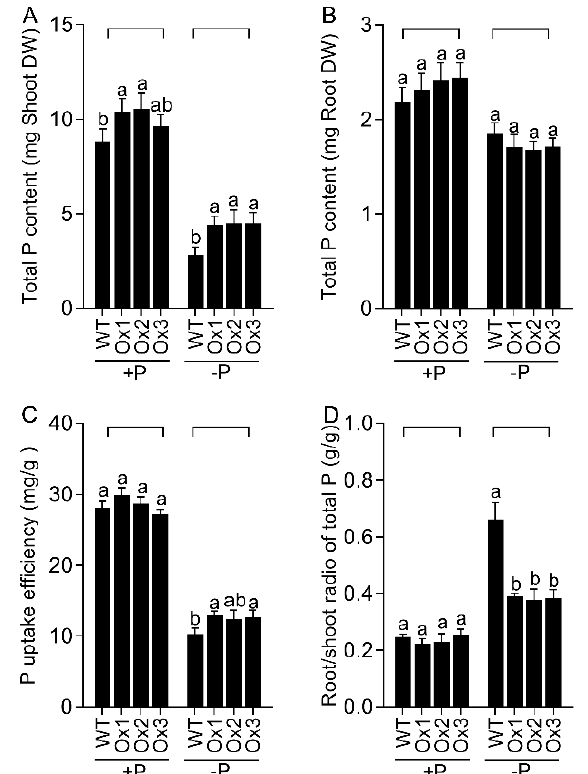
Figure 3. Overexpression of OsPHT1;4 elevated total P concentration in Pi-deprived shoot. WT and Ox1–Ox3 seedlings (10-d-old) were grown hydroponically in +P and − P media for 3 weeks. Tissues were harvested and assayed for their total P concentrations. Comparisions of total P content of shoot ( A ), total P content of root ( B ), P uptake efficiency ( C ) and ( D ) root/shoot ratio of total P of WT and Ox1–Ox3 plants grown under +Pi and − Pi regimes. Values are means ± SE ( n = 5). Different letters above the bars indicate significant differences ( p < 0.05, one-way ANOVA).